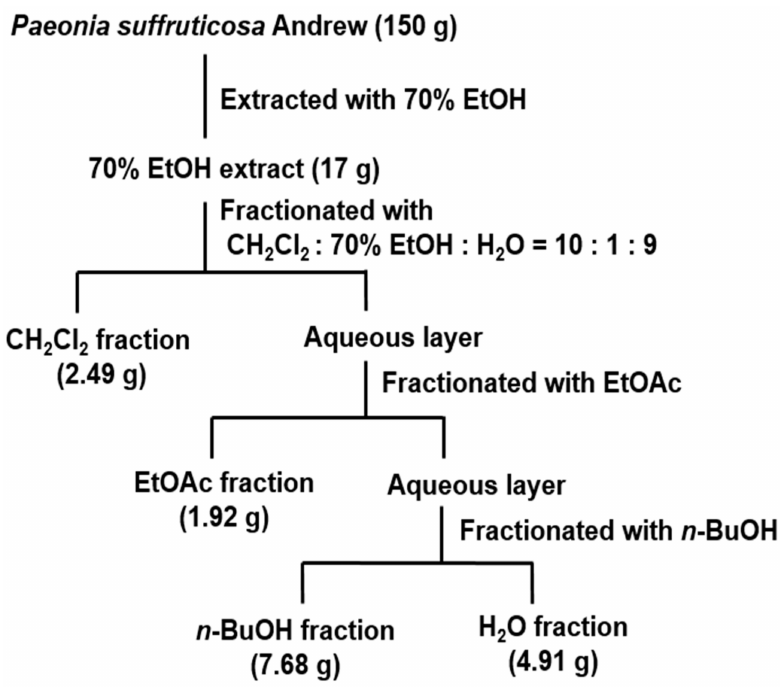
Figure 1. Extraction and fractionation from root bark of P. su ff ruticosa . Table 3. ONOO − scavenging activity of subfractions from the 70% EtOH extract of root bark of P. su ff